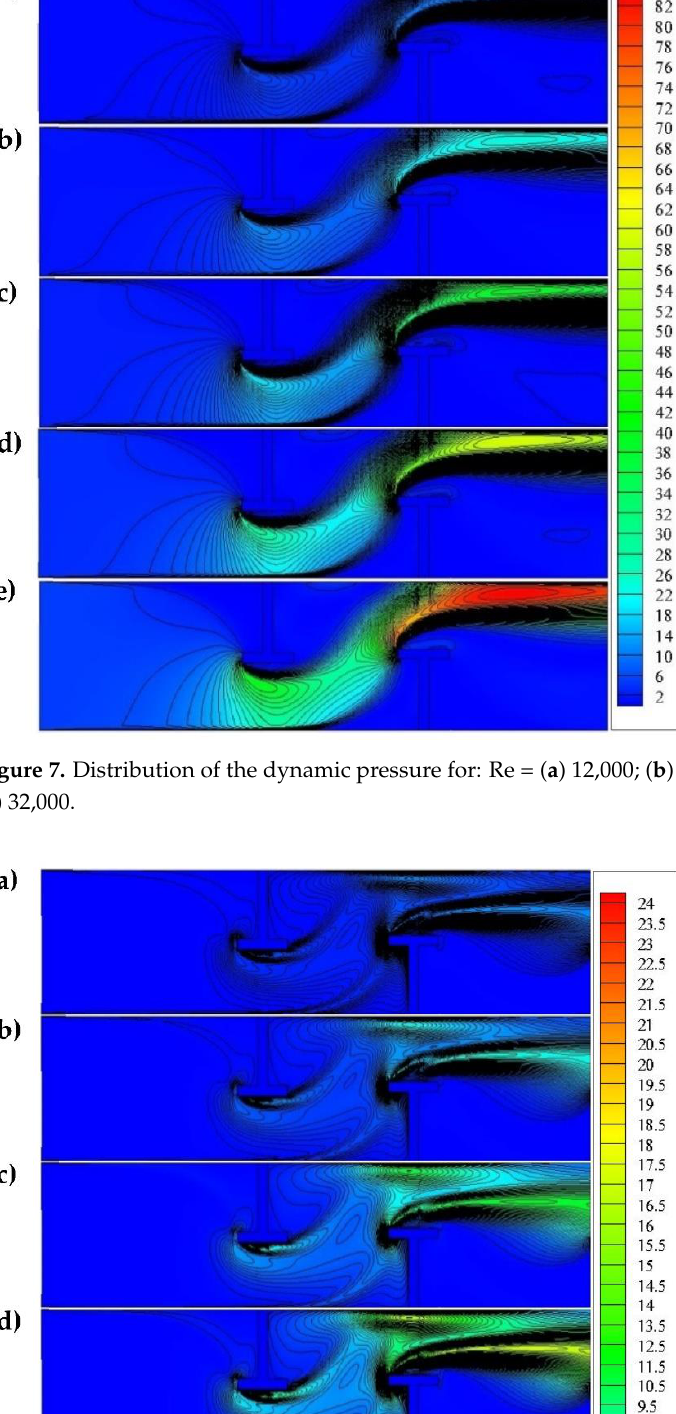
Figure 9. Fields of the turbulent dissipation rates for: Re = ( a ) 12,000; ( b ) 17,000; ( c ) 22,000; ( d ) 27,000; ( e ) 32,000.